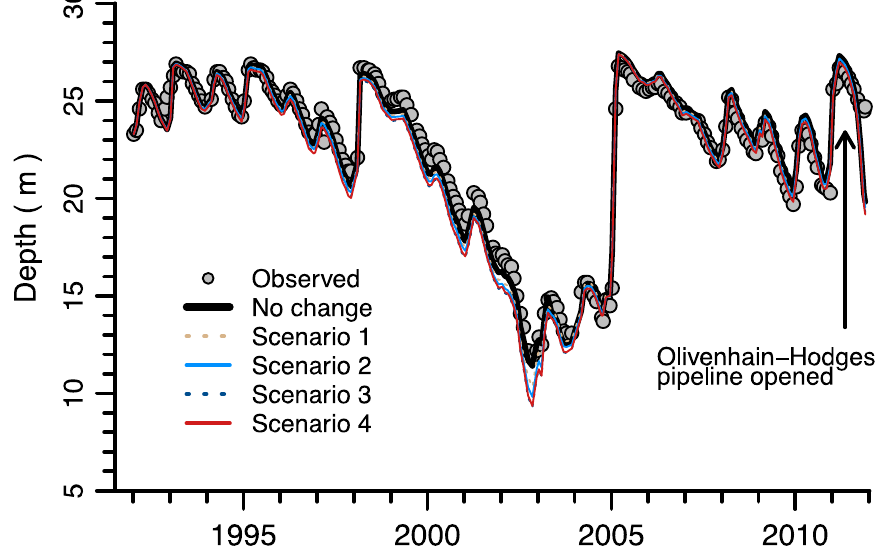
Figure 2. Water depth at Hodges from 6 January 1992 to 21 November 2011. Hodges began importing water from a nearby reservoir (Olivenhain Reservoir), which in turn received water from the California Aqueduct, near the end of the study period (June 2011).